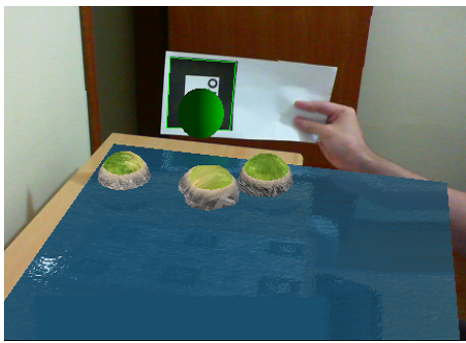
Fig. 9. Deformation using the sphere volume function.